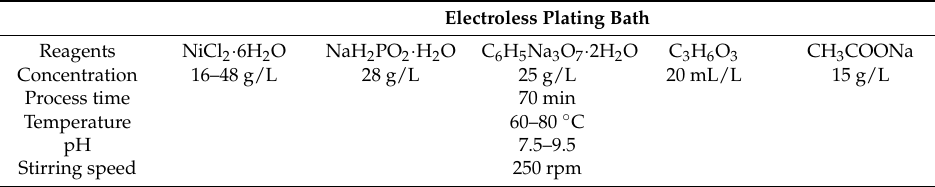
Table 1. Technological conditions of electroless plating.